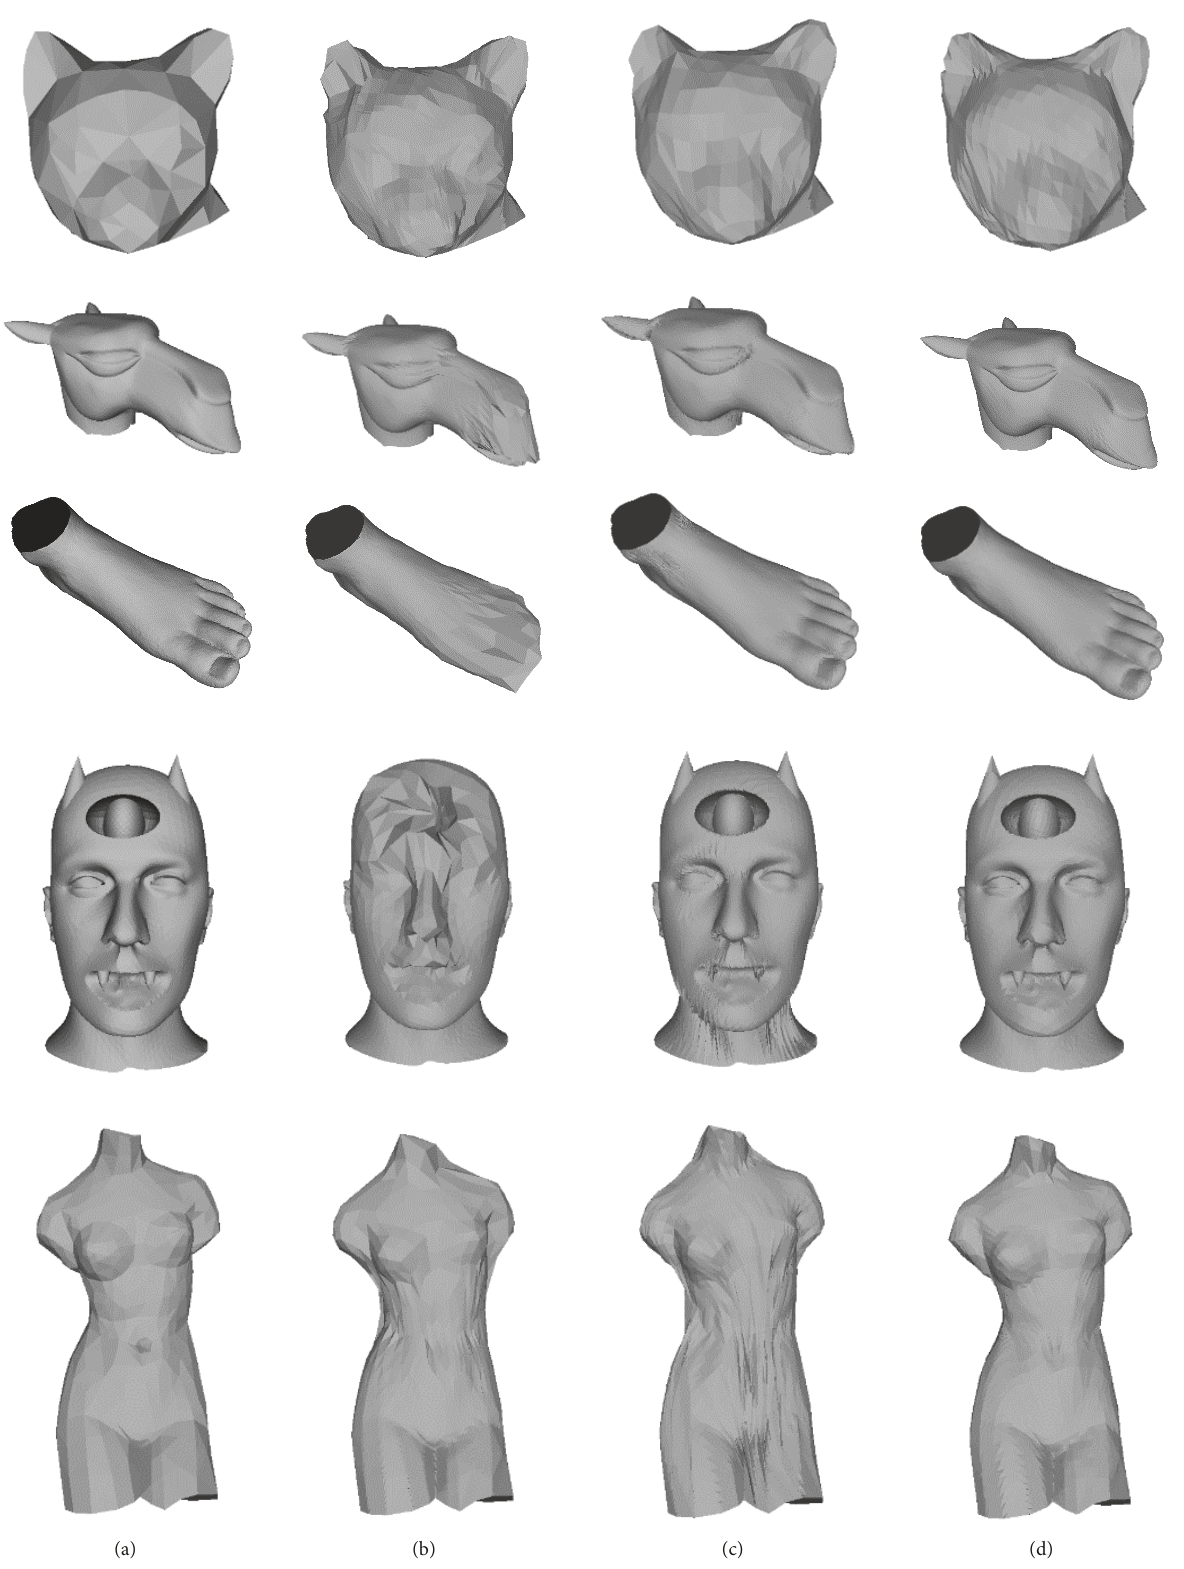
Figure 7: Qualitative results with different models. From (a) to (d): the original model, [4]’s sampling model, the regular sampling model, and our sampling